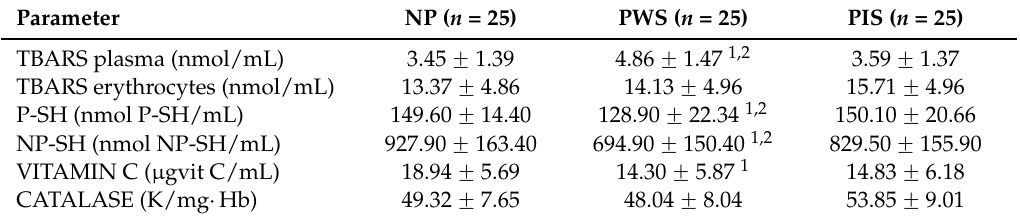
Table 3. Oxidative stress markers in pregnant and non-pregnant women.